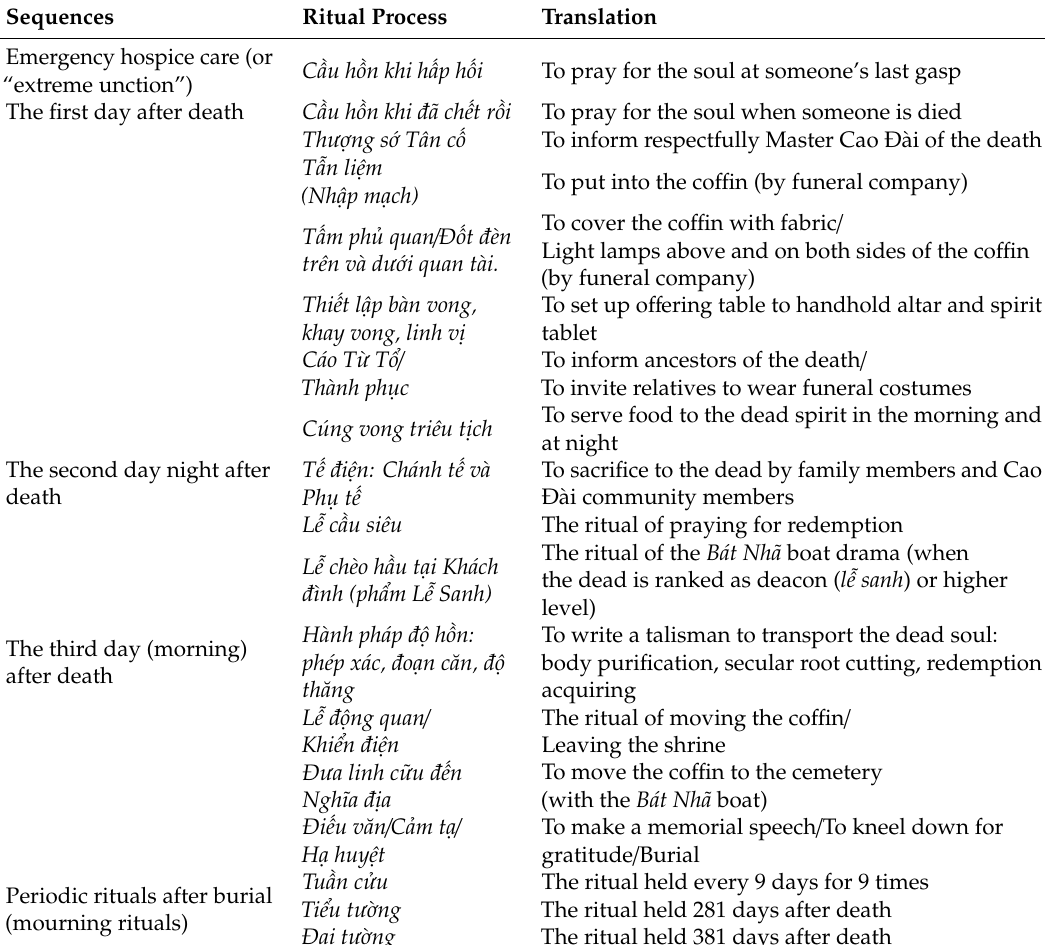
Table 1. Standard funeral ritual